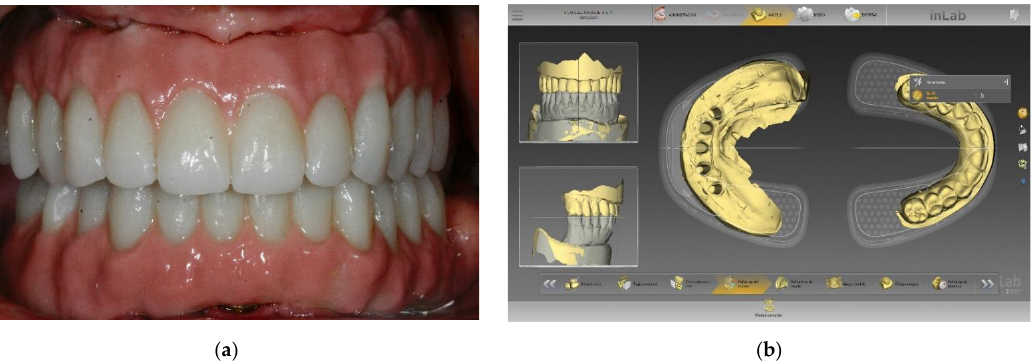
Figure 1. Clinical example of Y-TZP (Corcon ® htML Dentsply Sirona, York, PA, USA) used in an implant for definitive rehabilitation: ( a ) Frontal clinical view of the definitive prosthesis placed over five implants, ( b ) View of the design software used in this clinical case (inLab CAD Dentsply Sirona, York, PA, USA).